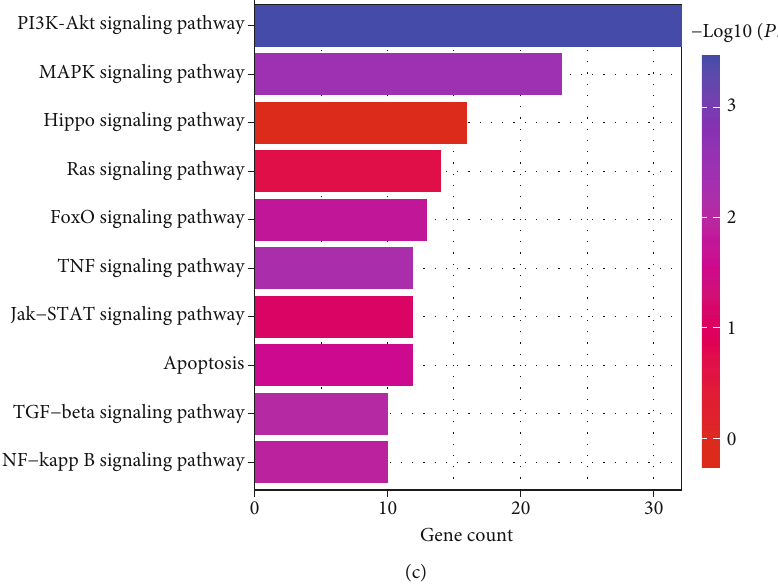
Figure 5: The Hippo pathway is involved in the e ff ects of Res on HSC inactivation. (a) Volcano plot of DEGs; the green dots represent downregulated DEGs, the red dots represent upregulated DEGs, and the black dots represent non-DEGs. (b) Heatmap. (c) KEGG